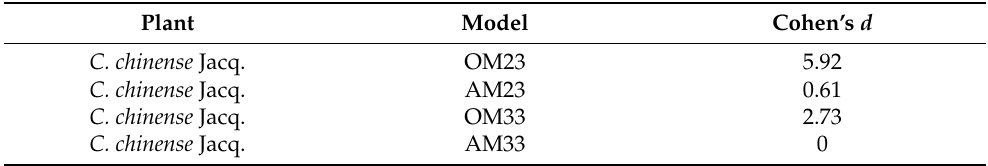
Table 6. The statistical values of the Capsicum chinense Jacq., Cohen’s d values, compared with the original model M23 (OM23), the fitted model M23 (AM23), the original model M33 (OM33), and the fitted model